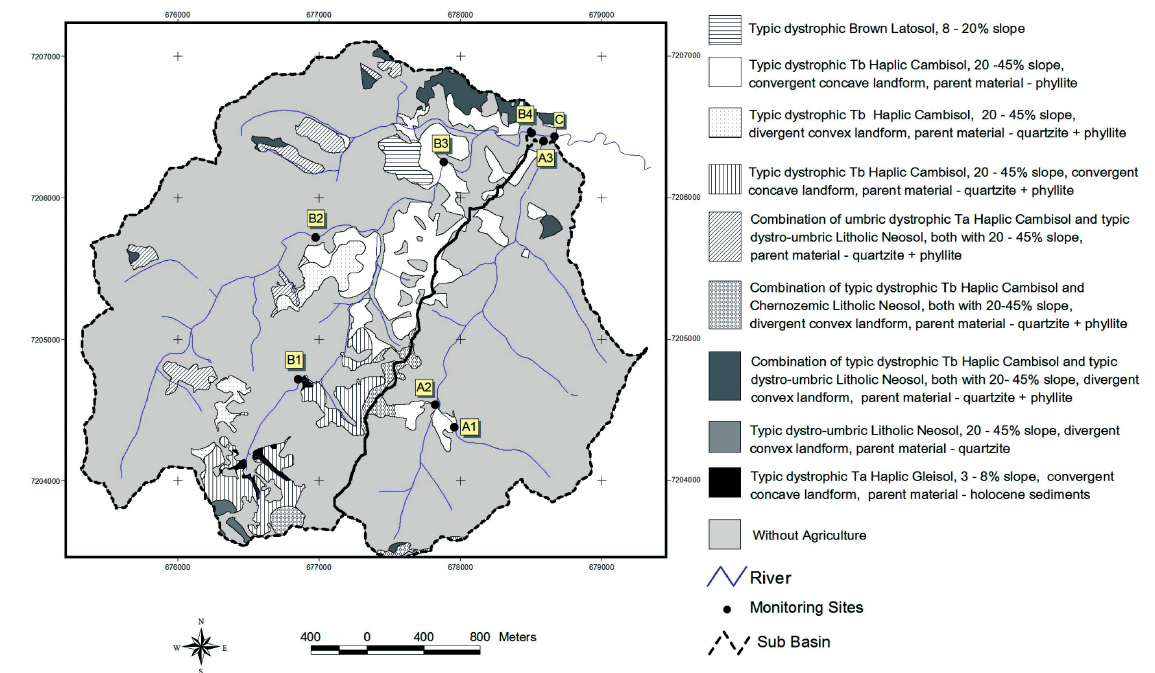
Figure 6. Soil units in the agricultural area in the Campestre